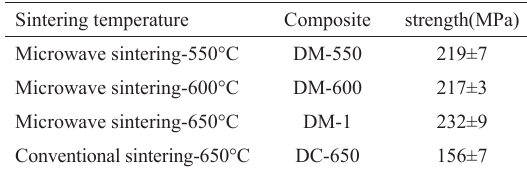
Table 5: Mechanical strength of aluminum composite sintered by two different methods Sintering